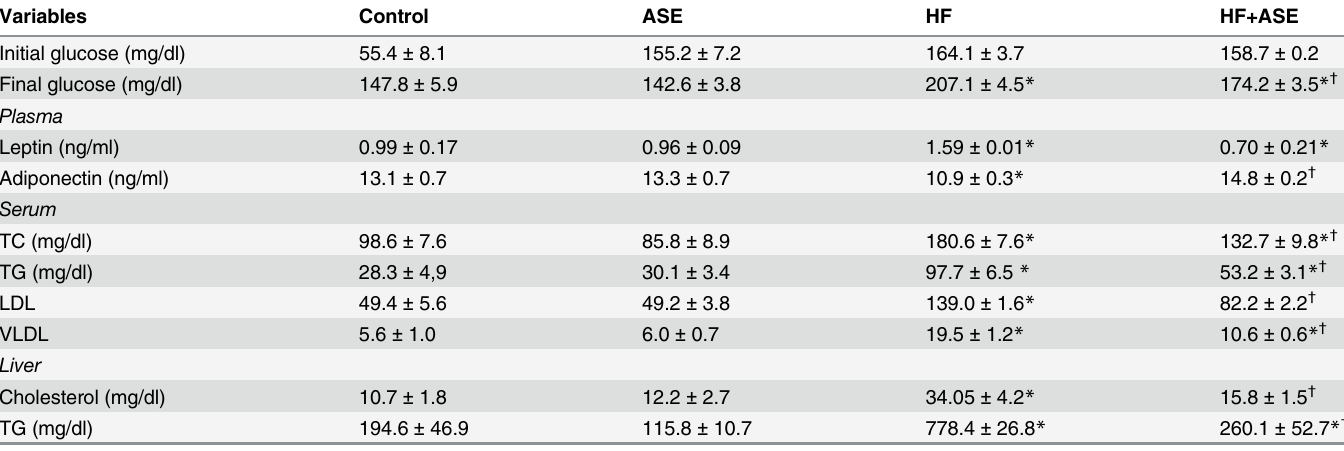
Table 3. Effects of HF diet and ASE on glycaemia, plasma adipokines, serum and hepatic lipid profile in C57BL/6 mice